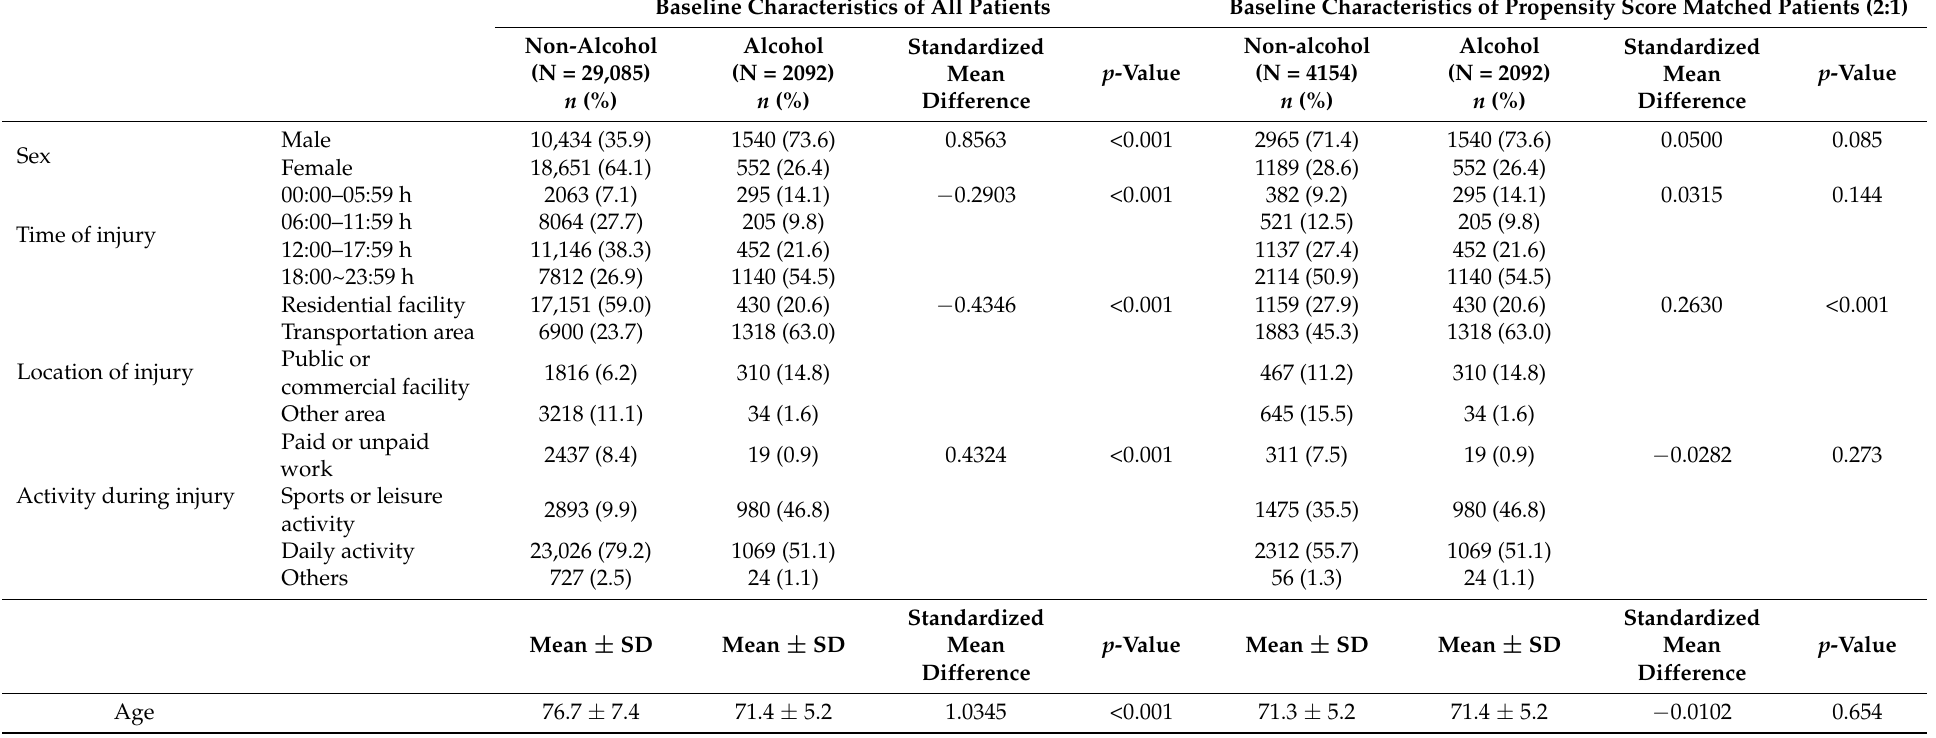
Table A1. Results of 2:1 propensity score matching